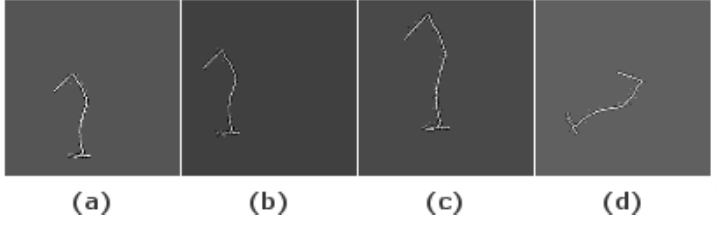
Figure 8. Images of original “1” image ( a ), translation ( b ), translation-scaling ( c ) and rotation ( d ). Gesture translation, scaling and rotation were selected as the data